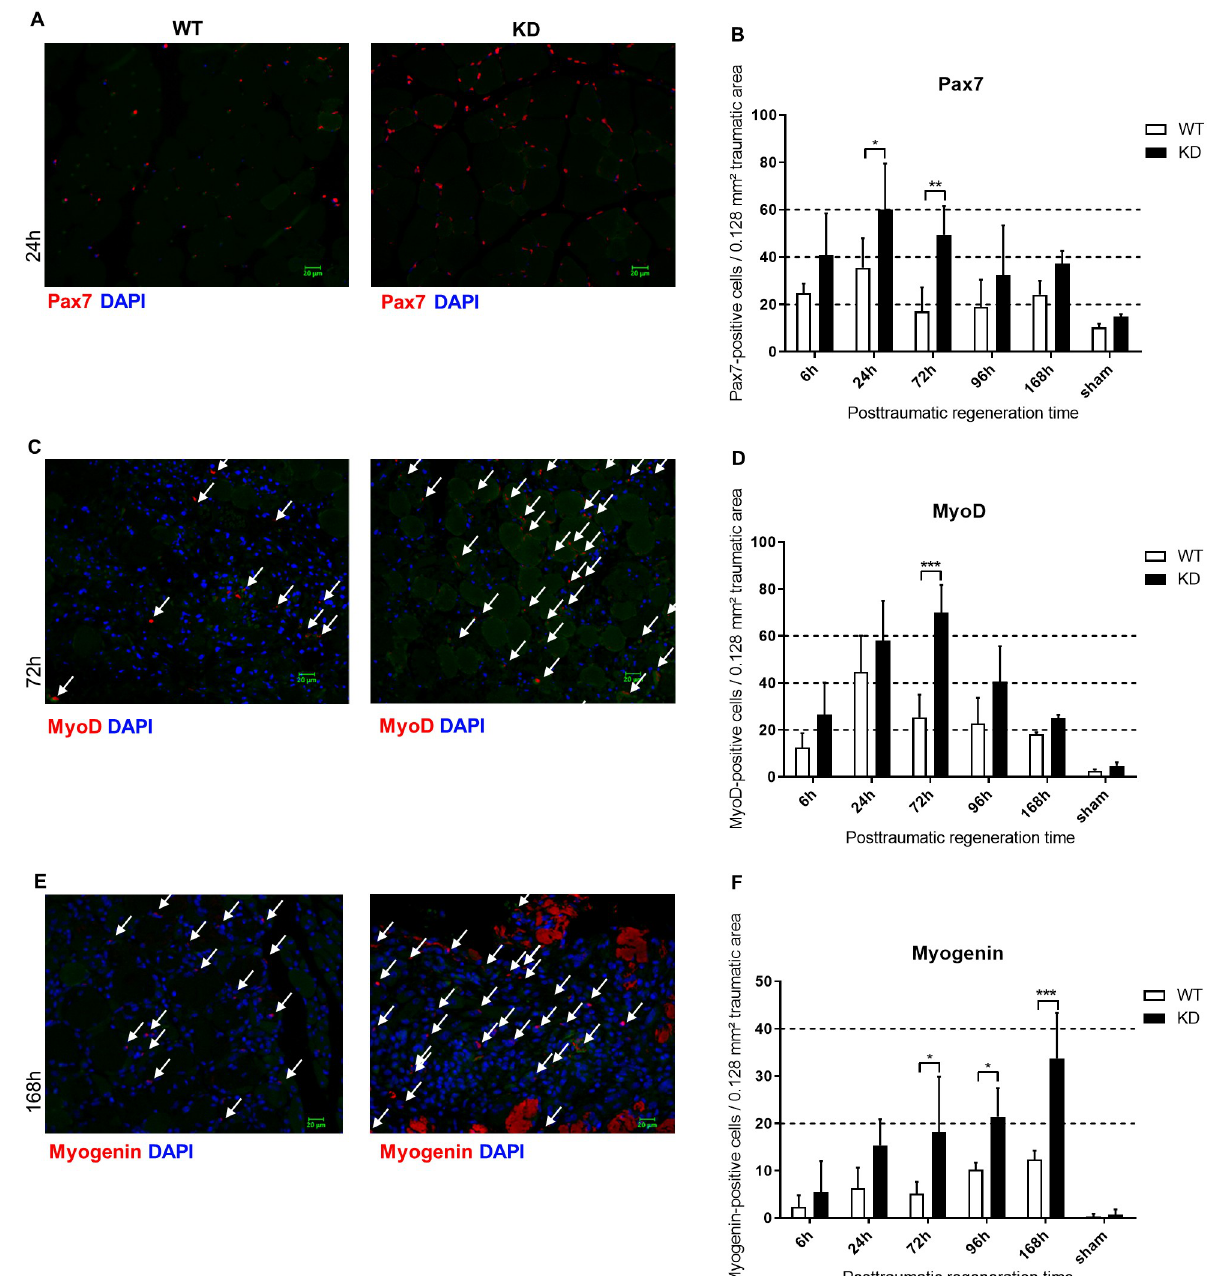
Fig 2. Skeletal muscle repair is enhanced in Phd2 -hypomorphic mice. (A/C/E) Immunofluorescence staining of Pax7, MyoD and myogenin in skeletal muscle of traumatic and sham treated wild type (WT) and Phd2 -hypomorphic (KD) mice (time periods after trauma application are indicated). Stained are Pax7 (red), nuclei (DAPI; blue), intrinsic fluorescence (green). Colours have been adjusted for visualization in a linear fashion. The myogenin signals in (E) are cellular signals, red-stained myofibers are artificial due to technical reasons. Shown are slides of 1 μ m thickness (200x magnification; scale bar: 20 μ m). (B/D/F) Pax7-, MyoD-, and myogenin-positive nuclei per 0.128 mm 2 area of trauma were counted from the stained slides. Time courses of induction of Pax7, MyoD and myogenin reveal subsequent activation of the named factors of the myogenic program. Inductions are significantly higher in Phd2 -hypomorphic mice. Mean ± SD; n 4–6; sham: n = 3. � P < 0.05, �� P < 0.01, ��� P < 0.001.